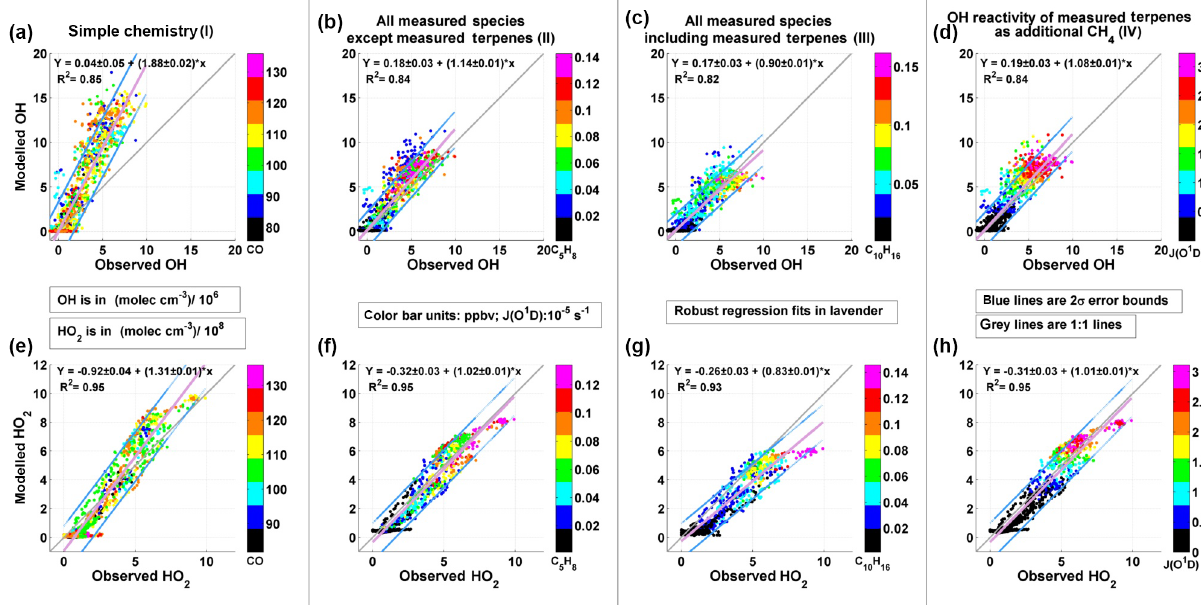
Figure 3. LIF-FAGE measurements of OH (a–d) and HO 2 (e–h) vs. model simulations with CAABA/MECCA. From left to right: model simulations using simple chemistry without NMHCs (case I), simulations including anthropogenic and biogenic hydrocarbons except ter- penes (case II), after adding terpenes (case III), and after initializing with zero terpenes but with CH 4 increased to account for the additional measured terpene reactivity (case